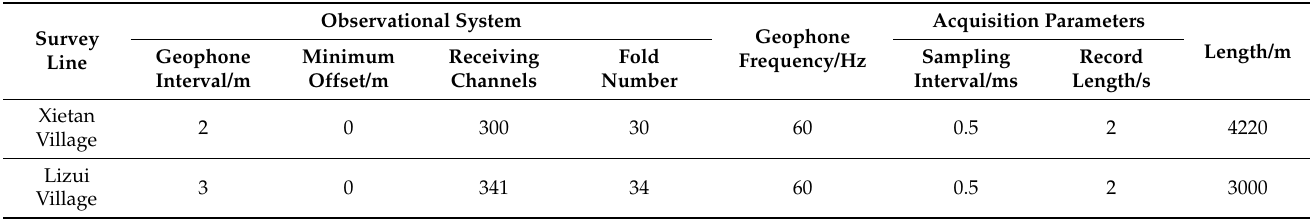
Table 1. The observational system and acquisition parameters of seismic